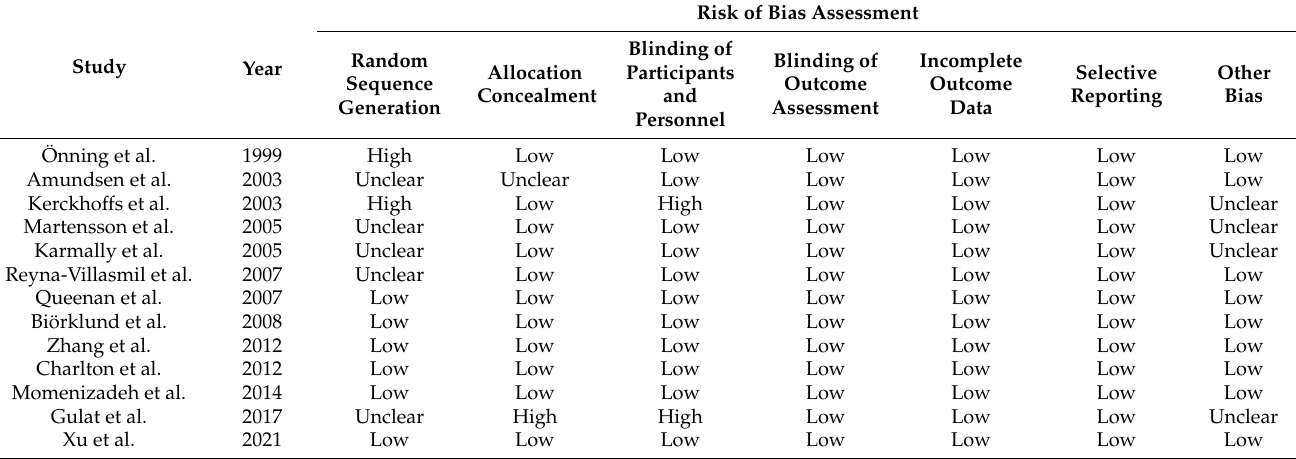
Table 2. Risk of bias